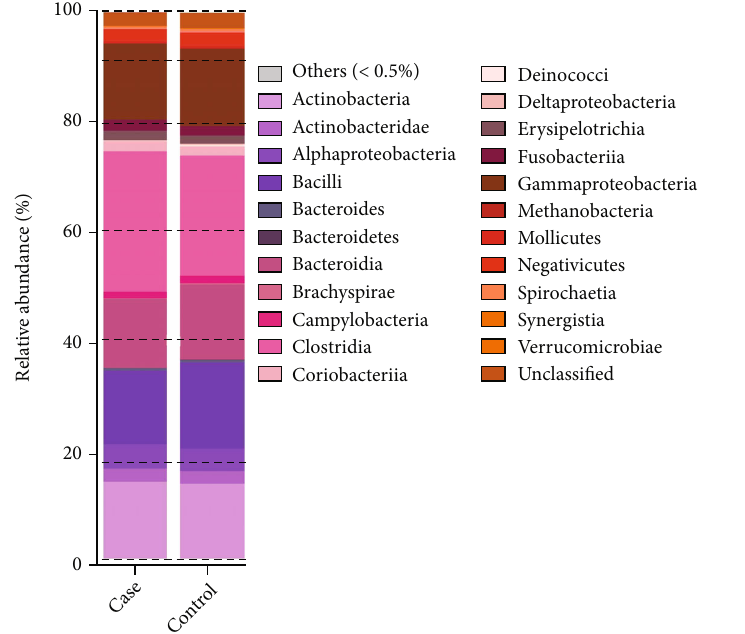
Figure 8: A column chart shows the relative abundances of species in the 2 groups at the genus level. The P values of the relative abundance of the intestinal microbiota of the 2 groups are the values after FDR